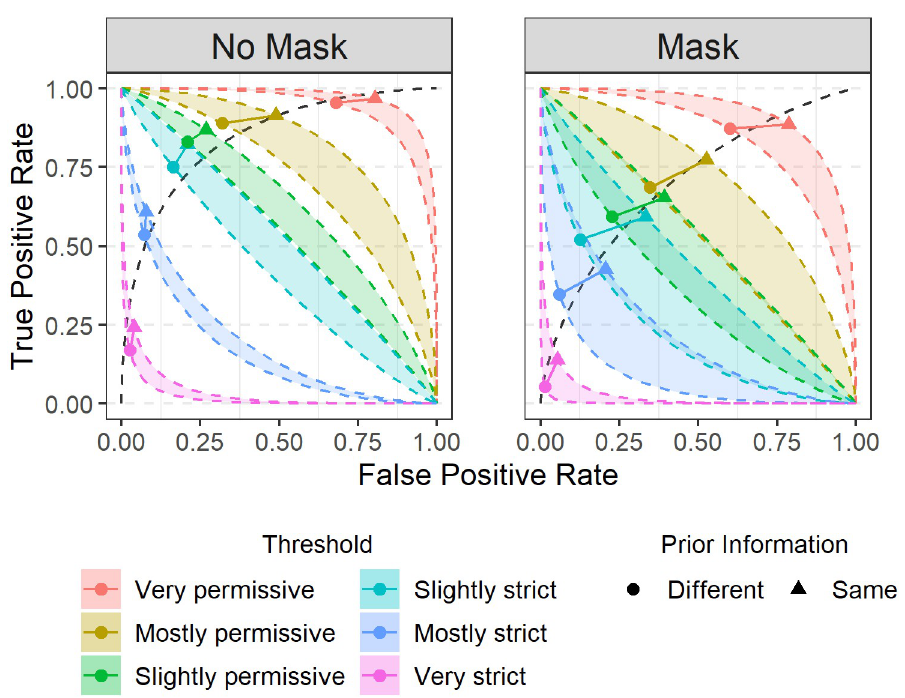
Fig 2. Isobias bands defined by shifts in responses by algorithm decisions across task conditions. Points denote measured TPR/FPR values computed as a function of decision threshold (legend). Lines join points associated with same/different algorithm decisions. Colored regions, isobias bands, are formed by curves in ROC space corresponding to constant criterion values for same and different algorithm decisions at each decision threshold (legend). Isobias band overlap indicates a that the shift in the cognitive criterion based on algorithm outcome is comparable to a full step along the decision confidence scale. There is very little overlap of isobands in the No Mask condition (left panel) whereas there are many regions that overlap in the Mask condition (right